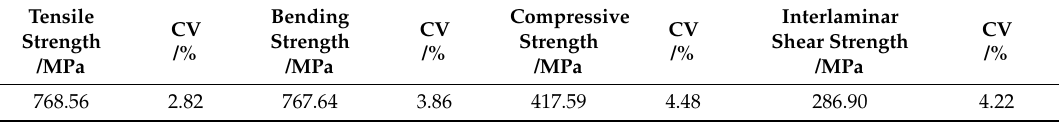
Table 3. Mechanical properties of composite sample molded by compression molding